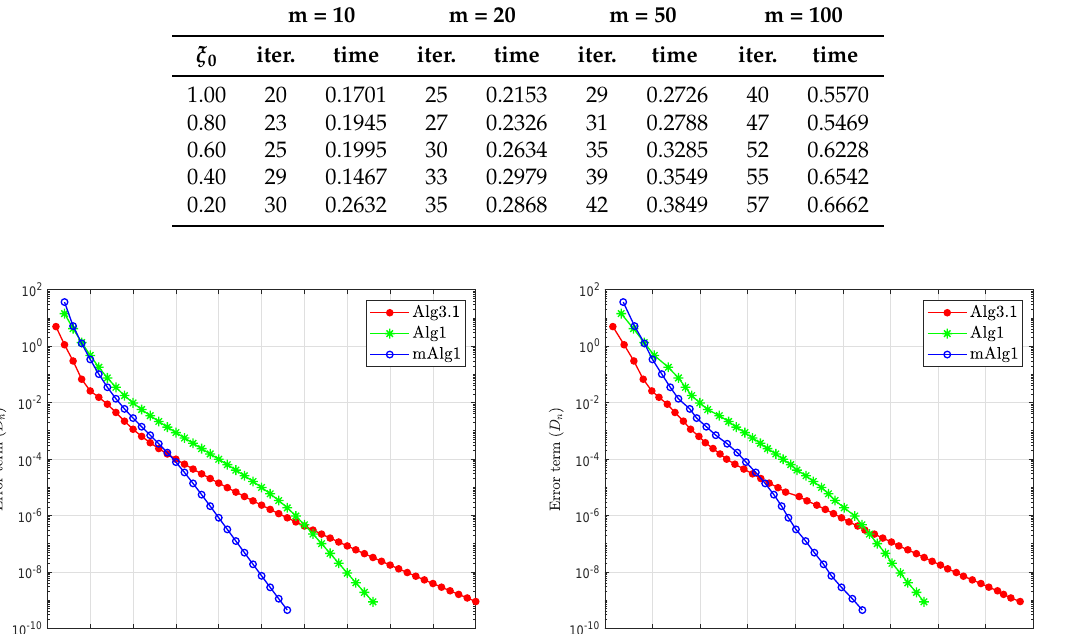
Figure 5. Example 1: Algorithm 1 (mAlg1) numerical comparison with Algorithm 3.1 (Alg3.1) in [39] and Algorithm 1 (Alg1) in [38] while m = 60.